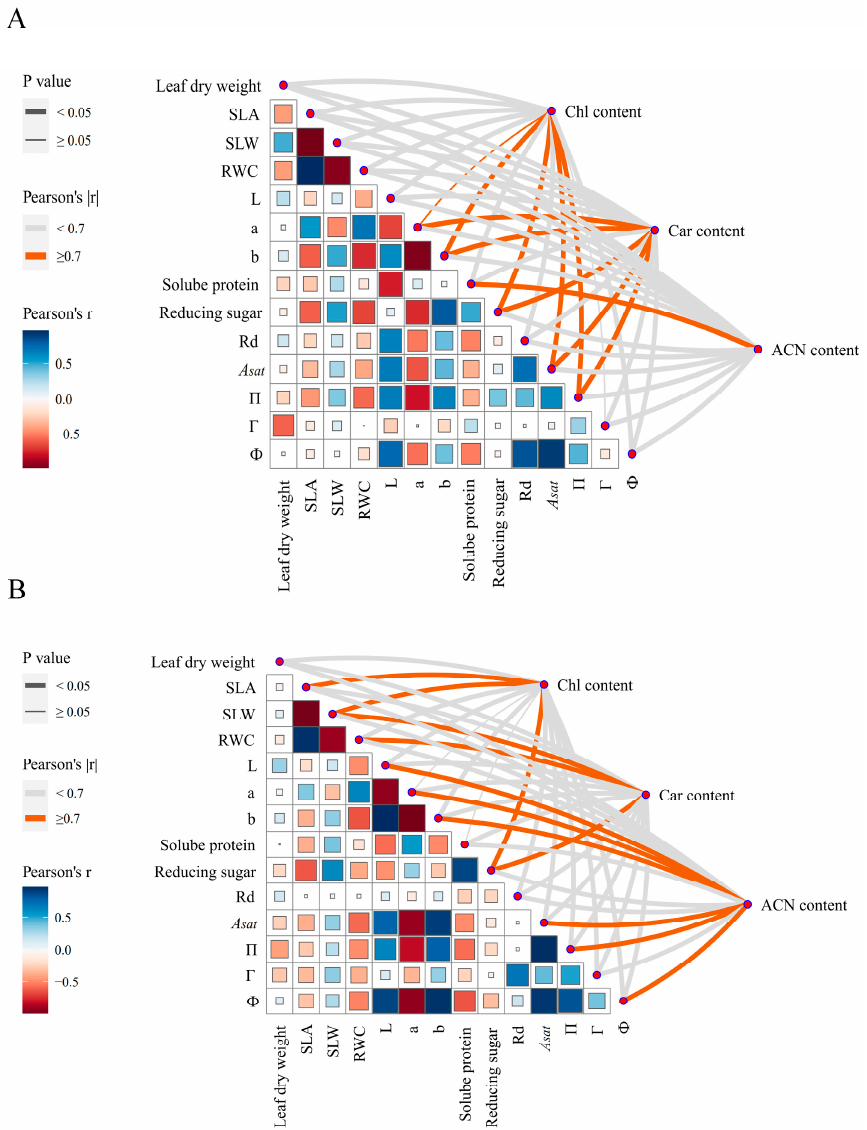
Figure 4. The Pearson association between chlorophyll, carotenoid, anthocyanin, and various indica- tors: ( A ) shade treatment; ( B ) sun treatment. Correlations between leaf characteristics, physiological indexes, and pigment contents. Pairwise comparisons of leaf characteristics and physiological indexes were shown, with the color gradient in heatmap corresponding to Pearson’s correlation coefficient. The relative contents of chlorophyll, carotenoid, and anthocyanin were related to the first two factors by correlation and significance analysis. Line width indicates the statistical significance based on p < 0.05, and the color corresponds to Pearson’s |r|